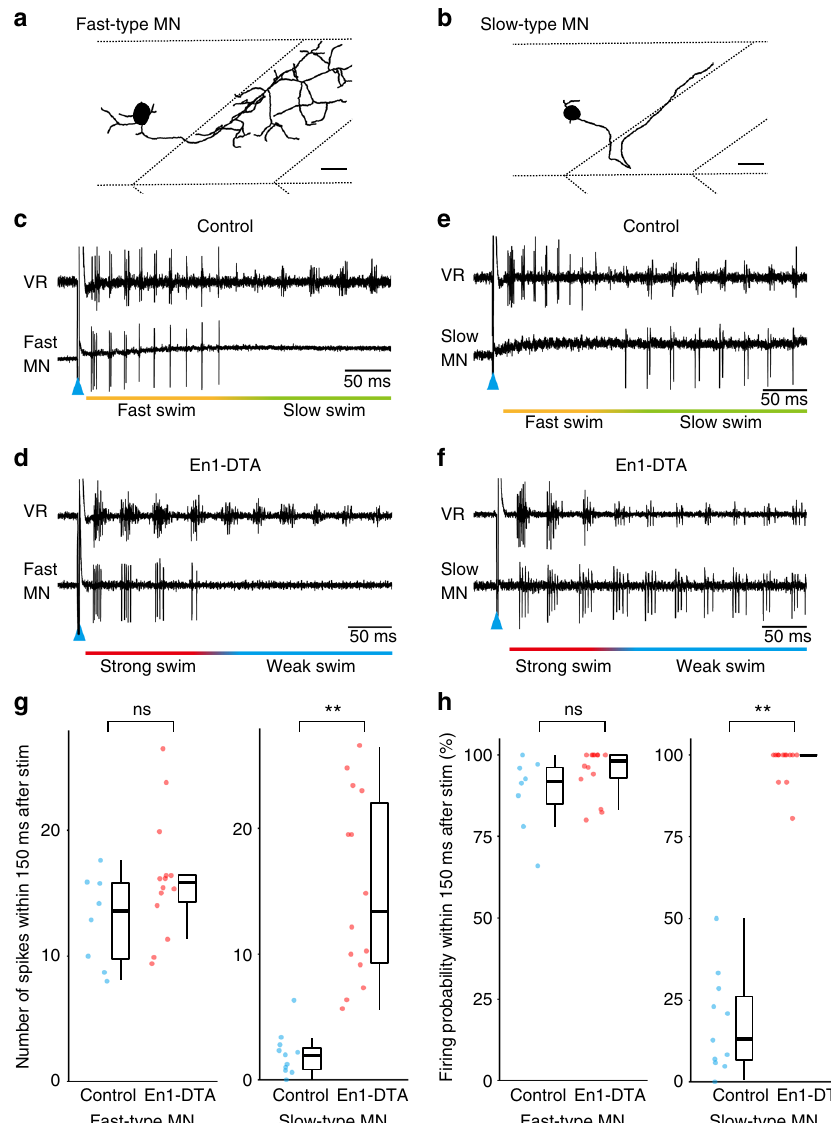
Fig. 3 Activity of motoneurons (MNs) in control and En1-DTA fi sh during fi ctive swimming. a Typical morphology of fast-type MNs. The horizontal dotted line at the top indicates the dorsal boundary of the trunk muscles. The horizontal dotted line at the bottom indicates the boundary of the dorsally located muscles and ventrally located muscles. Scale bar, 20 μ m. b Typical morphology of slow-type MNs. Scale bar, 20 μ m. c Example of simultaneous recordings between fast-type MNs (loose-patch) and ventral root (VR) in control fi sh. d Example of simultaneous recordings between fast-type MNs and VR in En1- DTA fi sh. e Example of simultaneous recordings between slow-type MNs and VR in control fi sh. f Example of simultaneous recordings between slow-type MNs and VR in En1-DTA fi sh. g , h Numbers of spikes ( g ) and fi ring probability in each cycle ( h ) during fast/strong swim. Each circle represents each cell ( n = 8 for fast-type MNs in control [ n = 6 for PMNs, n = 2 for dvs]; n = 14 for fast-type MNs in En1-DTA [ n = 8 for PMNs, n = 6 for dvs]; n = 11 for slow- type MNs in control; n = 14 for slow-type MNs in En1-DTA). ** P < 0.01 (Mann – Whitney U test, P = 0.14 [ g , fast-type MNs], P = 3.5 × 10 − 5 [ g , slow-type MNs], P = 0.11 [ h , fast-type MNs] for fast-type MNs, P = 1.2 × 10 − 5 [ h , slow-type MNs]). ns, not signi fi cant. Boxes represent the interquartile range (IQR) between fi rst and third quartiles and the line inside represents the median. Whiskers denote the lowest and highest values within 1.5 × IQR from the fi rst and third quartiles,